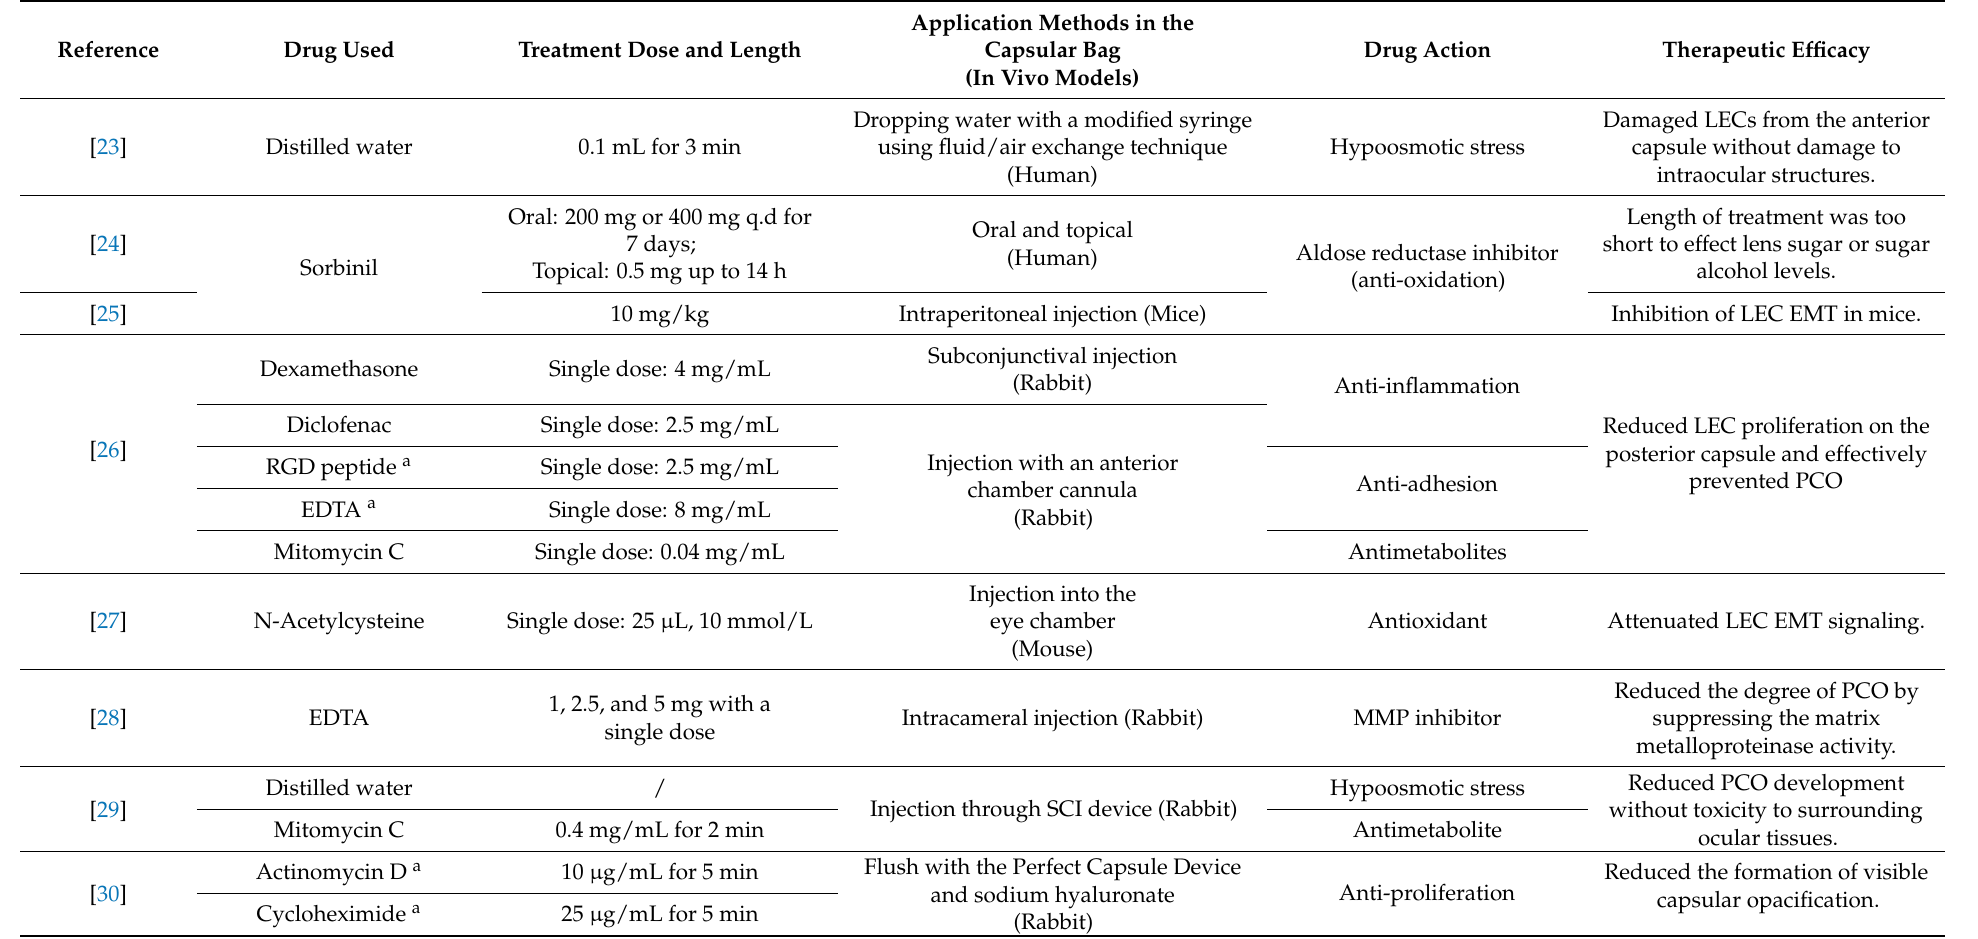
Table 1. Conventional pharmacological approaches to PCO